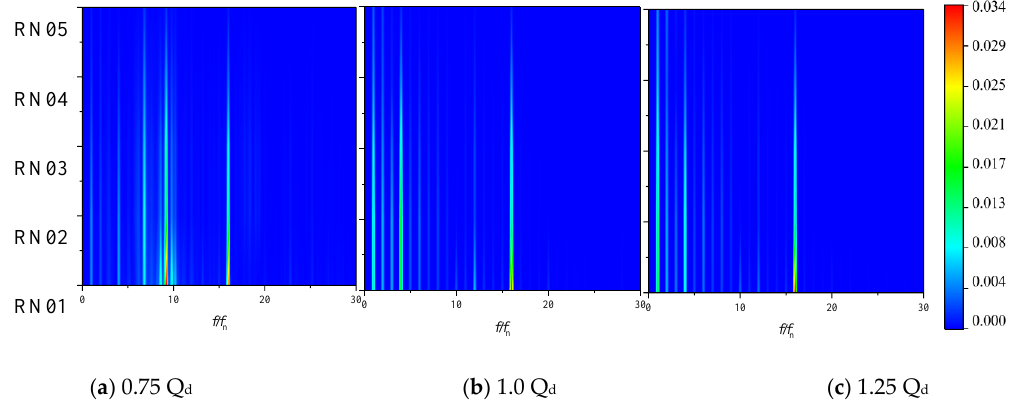
Figure 9. Frequency domain of pressure fluctuation near the pressure side of the long blade.